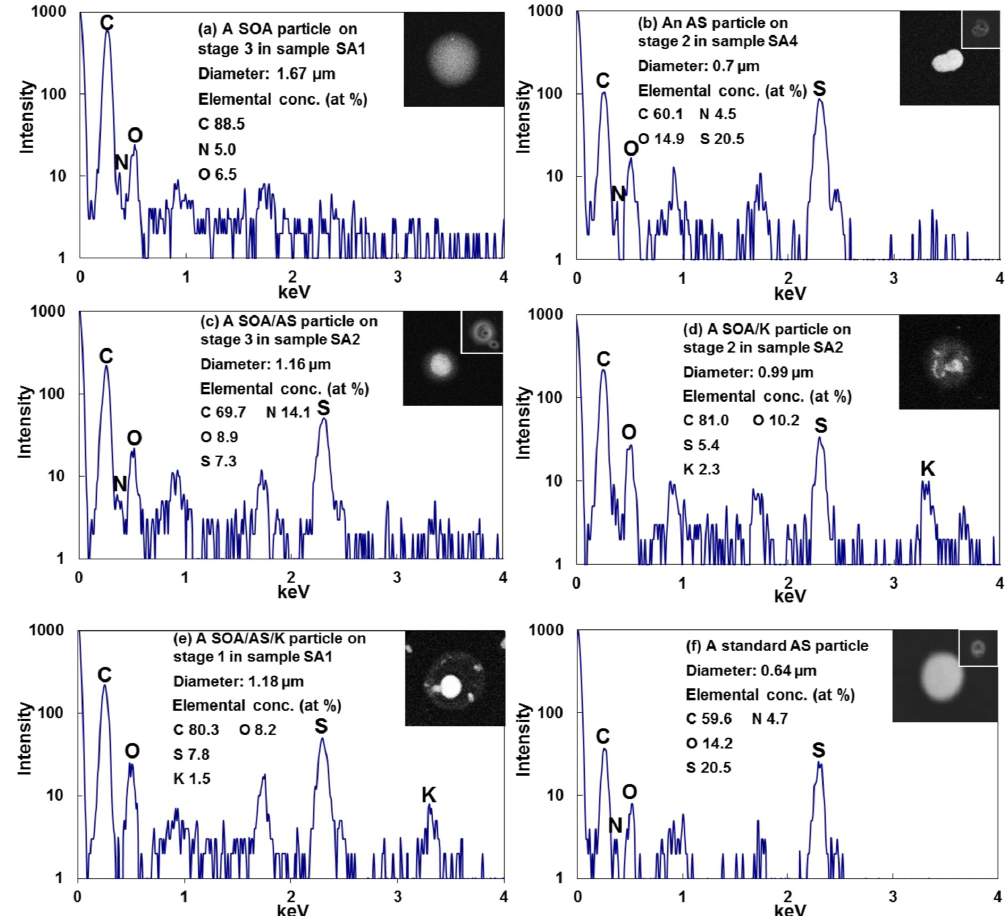
Figure 6. SEIs, X-ray spectra, and element atomic concentrations of SOA, ammonium sulfate (AS), and mixture particles. The inset images in (b) , (c) , and (f) show the beam damage on the particles after X-ray